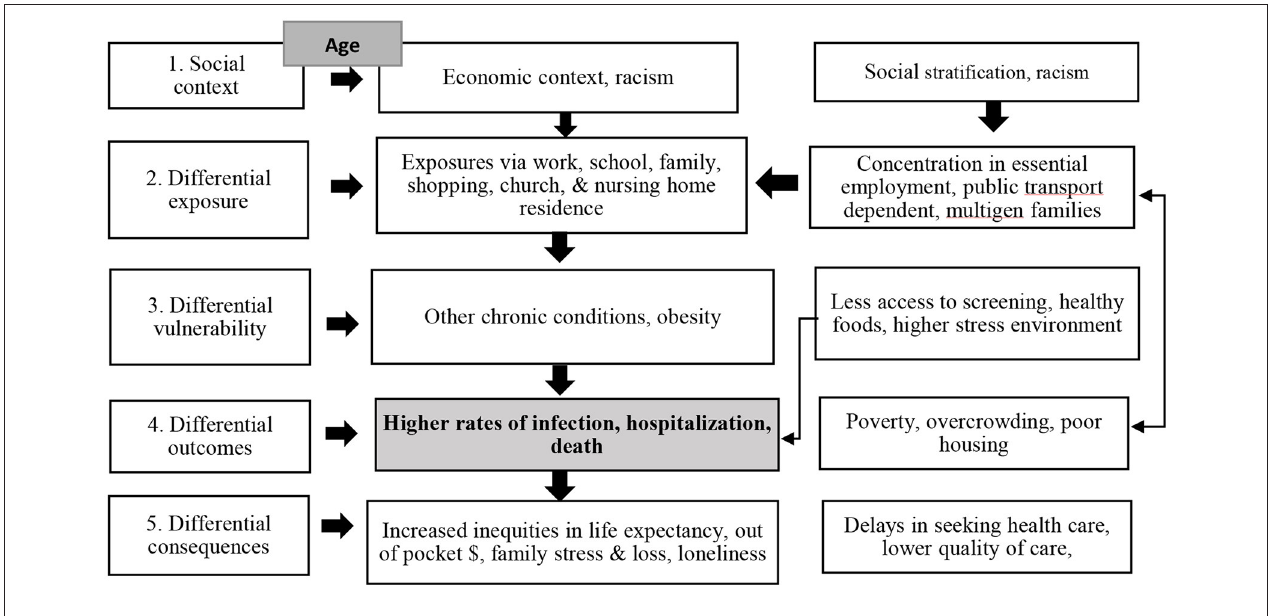
FIGURE 1 | Health inequity causal model.